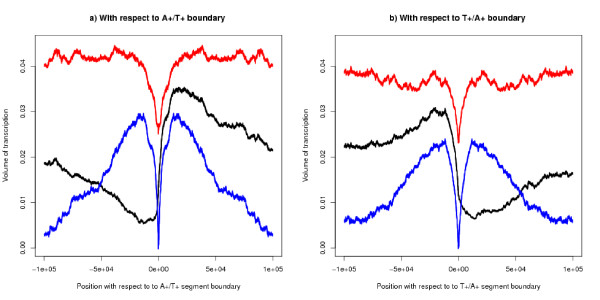
Volume of expression by position with respect to segment boundaries – estimated from expression data. With respect to (a) A+/T+ boundaries; (b) T+/A+ boundaries. For both graphs, the unsymmetric black line shows the volume of transcription along one strand from left to right – transcription with the flow of the segment bias is on the right for (a), and on the left for (b). The peak is about 15 kb to 20 kb downstream/upstream of the segment boundary. Corresponding data for both sides of the boundary have been averaged. The upper red line plots the sum of the amounts on the two strands and the blue line plots their absolute difference. All three lines show moving averages over 100 bases and the thickness of the lines show 95% confidence limits. For both (a) and (b), a two-tailed z-test shows that the black line at position +5000 bases is statistically different from that at position -5000: a) p < 10-50, n1 ~ 2058, n2 ~ 856, z = 16.5: b) p < 10-50, n1 ~ 2253, n2 ~ 1260, z = 16.6.